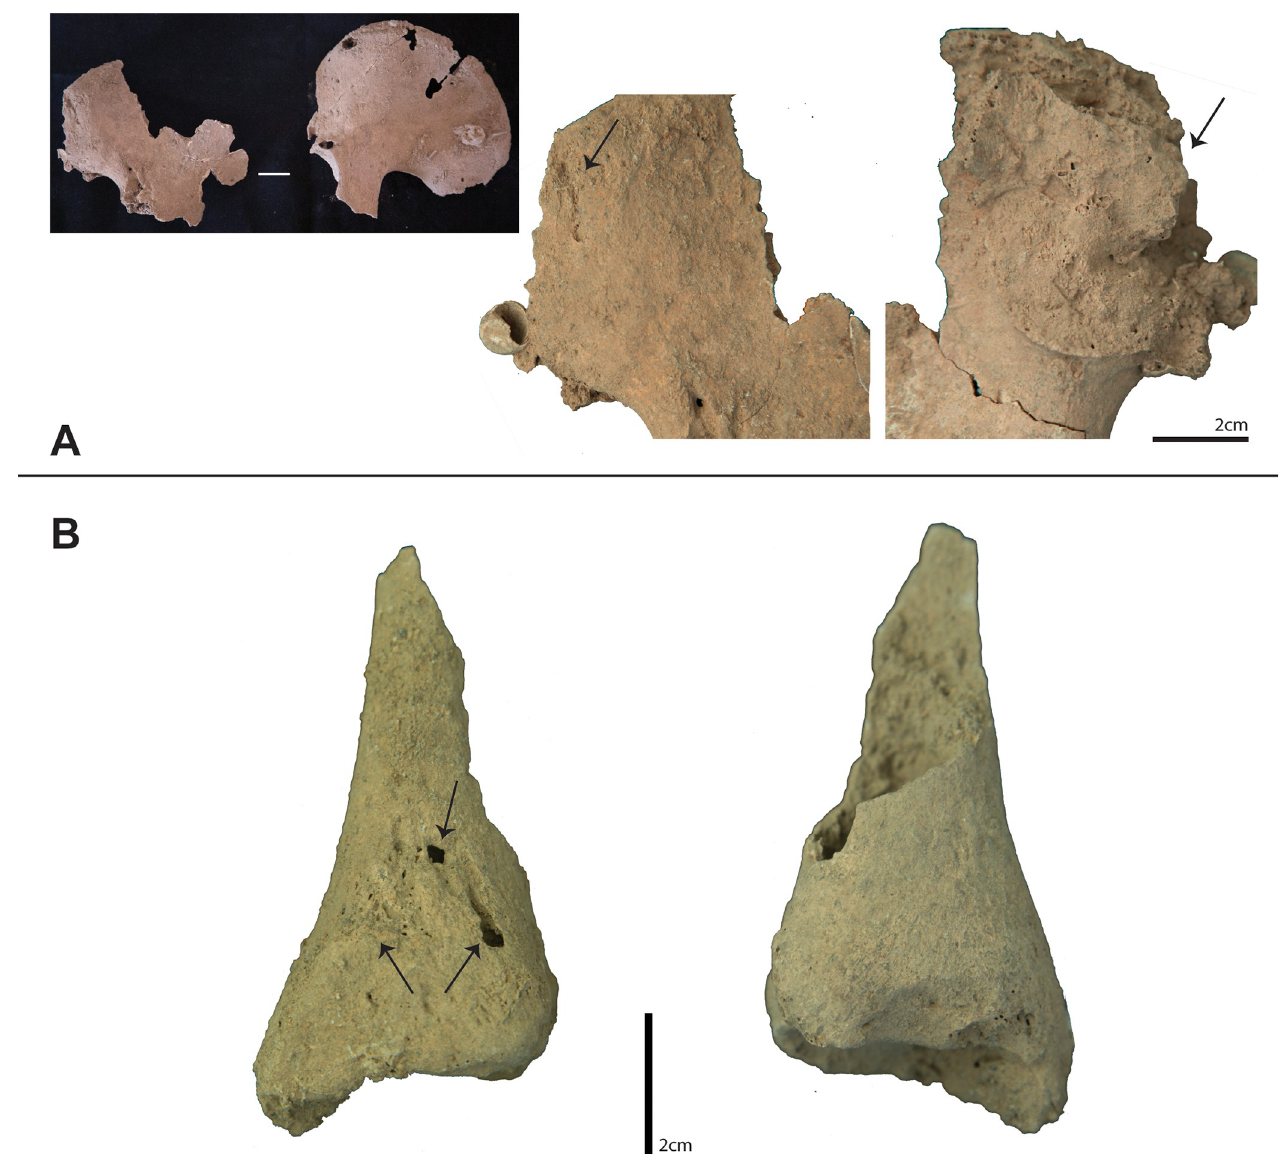
Fig 5. Postcranial pathologies in TLB-1. A) Lesion in right ilium. Comparison between right and left ilia (rectangle). Note the abrupt end of the right ilium after the greater sciatic notch. Detail of the cloacae (left, black arrow) on the lateral, and new bone formation (right, black arrow) on the auricular surface on medial; B) Detail of right distal tibia with two cloacae and pitting on the posterior side. Note spiral breakage morphology.